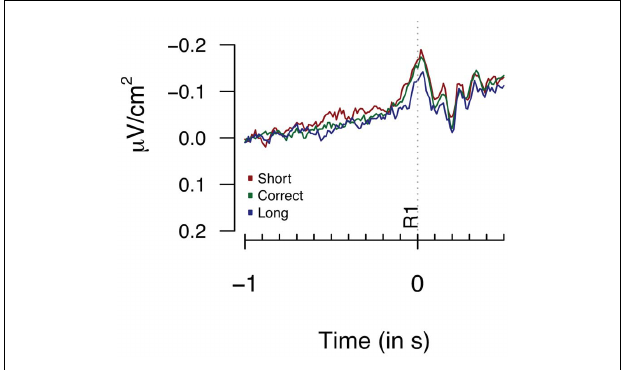
FIGURE 5 | Laplacians obtained at FCz during Experiment 1 as a function of participants’ behavioral performance, plotted time-locked to the first key press (R1). Averages are based on eight